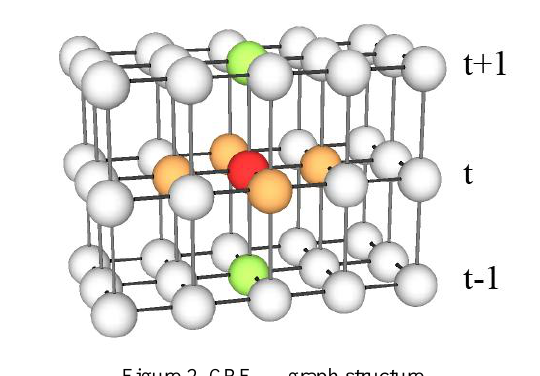
Figure 2. CRF multi graph structure.